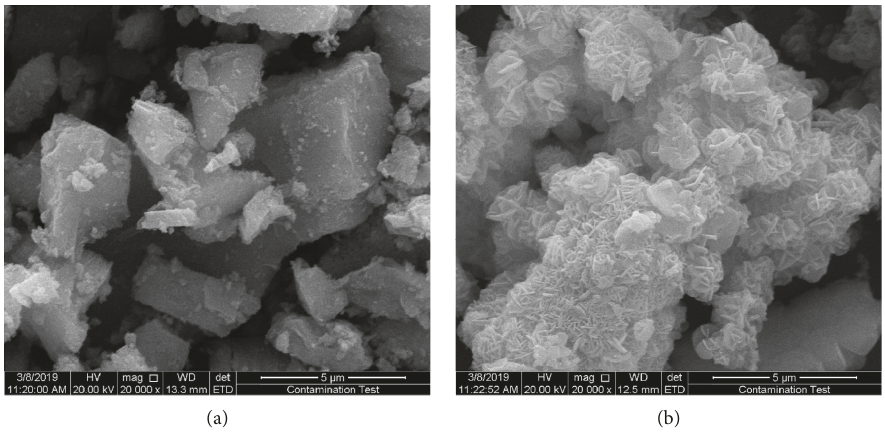
Figure 7: SEM images of MgO and its hydration products: (a) MgO; (b) hydration